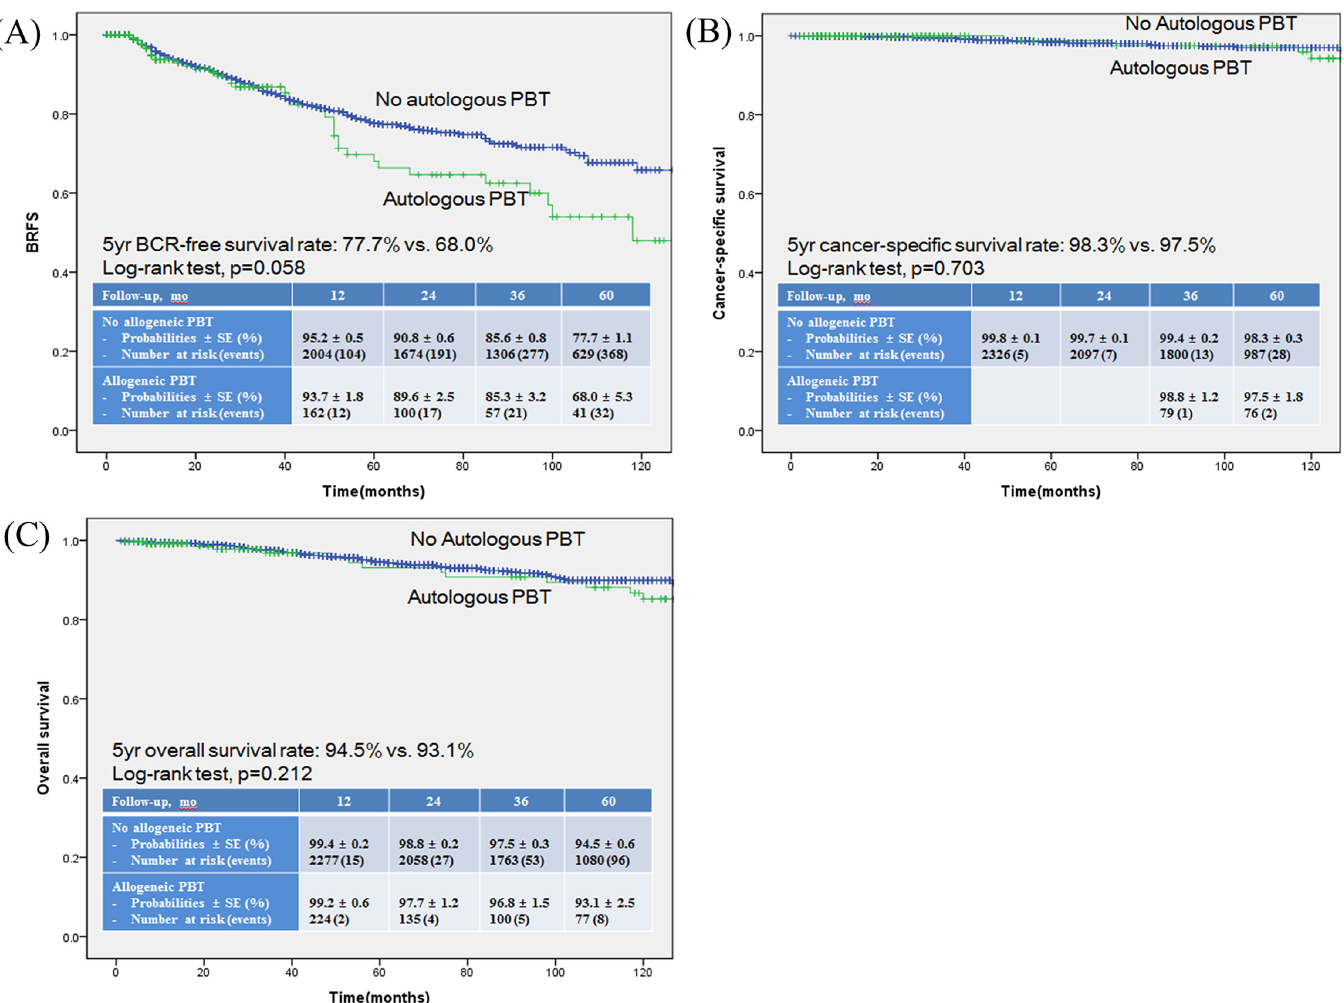
Fig 2. Kaplan-Meier survival curves for (A) BCR-free survival (BRFS), (B) Cancer-specific survival (CSS) and (C) Overall survival (OS) according to the administration of autologous perioperative blood transfusion